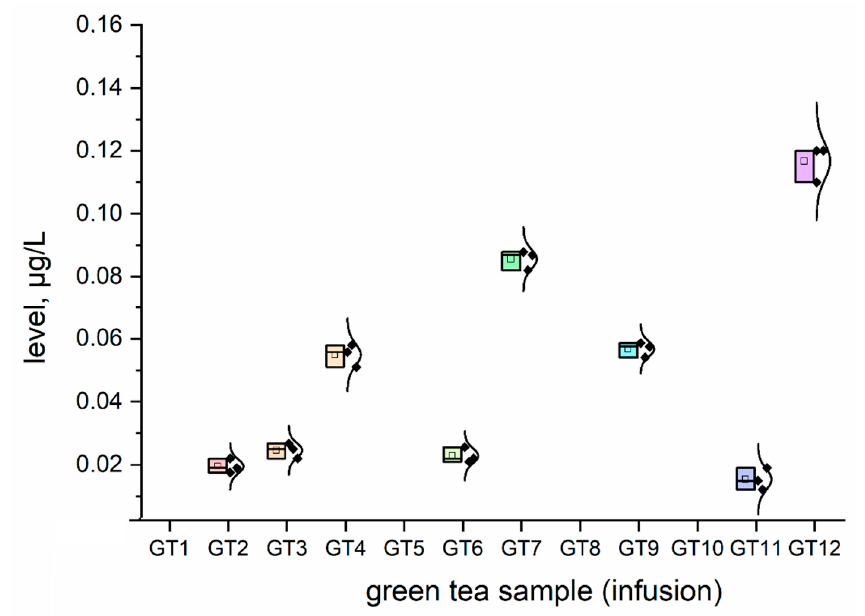
Figure 5. The plot as a box chart, with a normal distribution curve for Mo concentration ( µ g/L) in analysed green tea samples (infusions; GT1–GT12). The colors indicate the results for the individual tested samples, the symbol indicates the standard deviation.